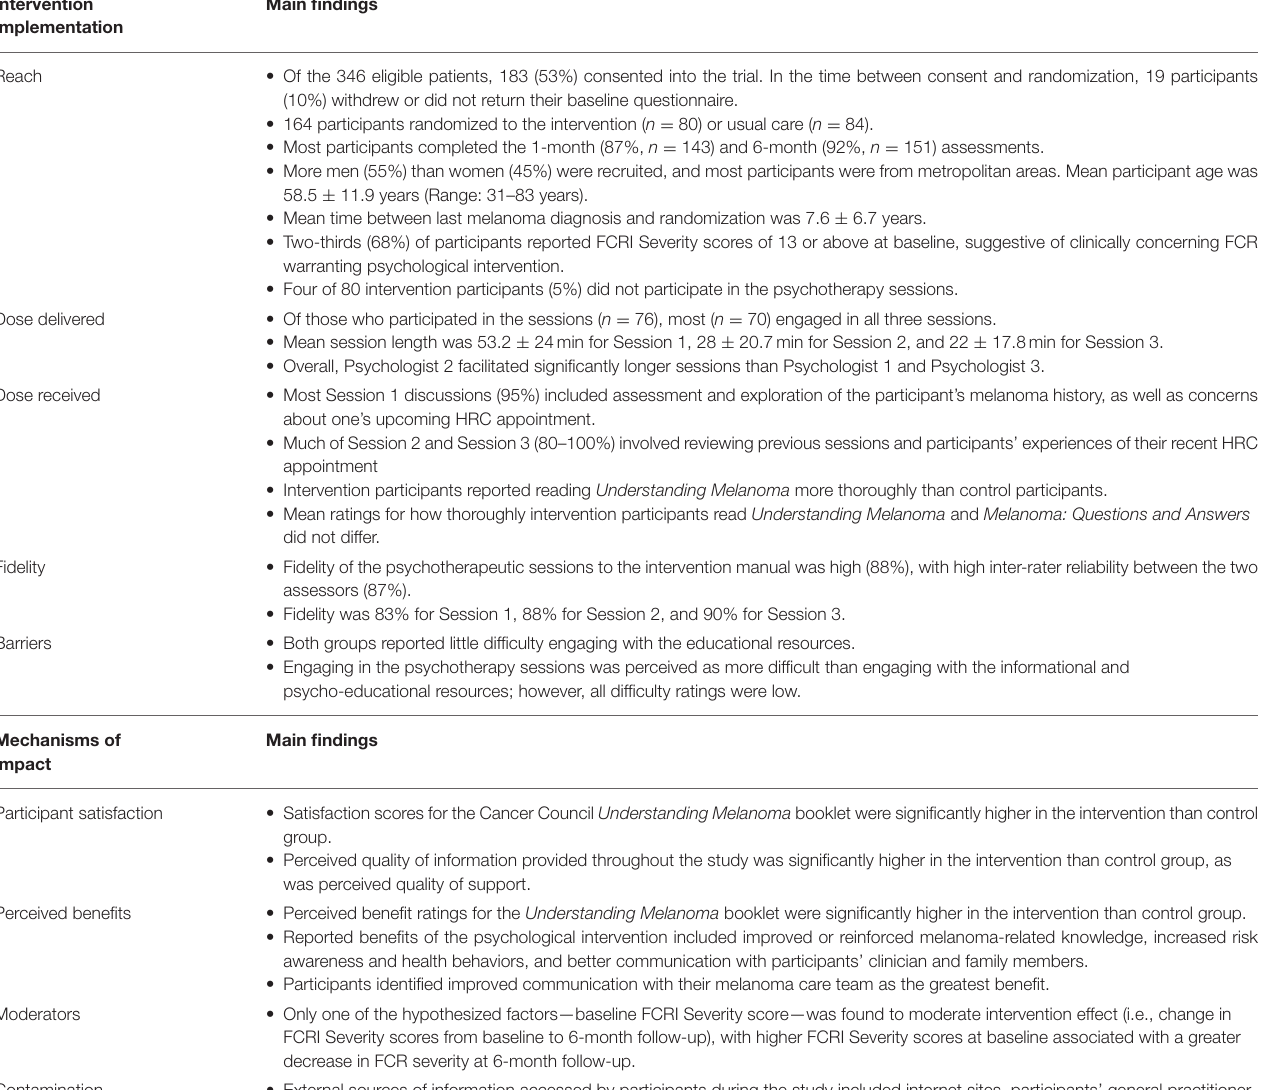
TABLE 7 | Summary of the main findings of the process